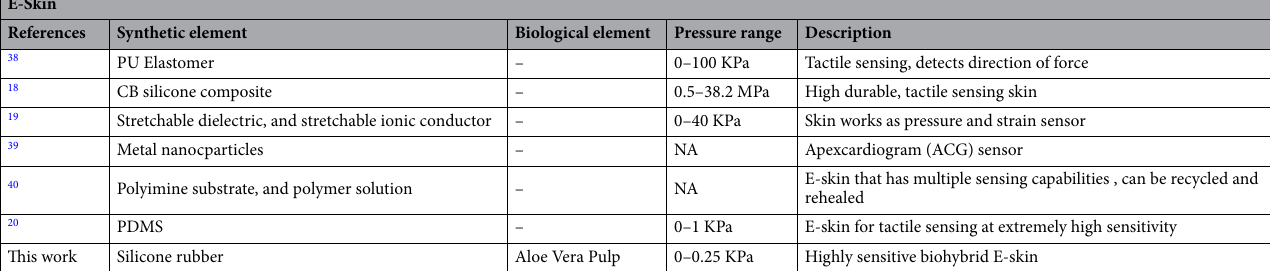
Table 1. Summary of the Biohybrid soft robots, and the E-skin research mentioned in this